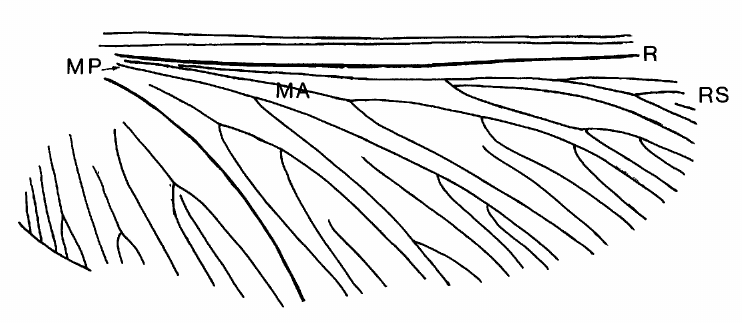
Fig. 2. Syntonoptera schucherti Handlirsch, hind wing. Venational pattern of specimen in Fig.